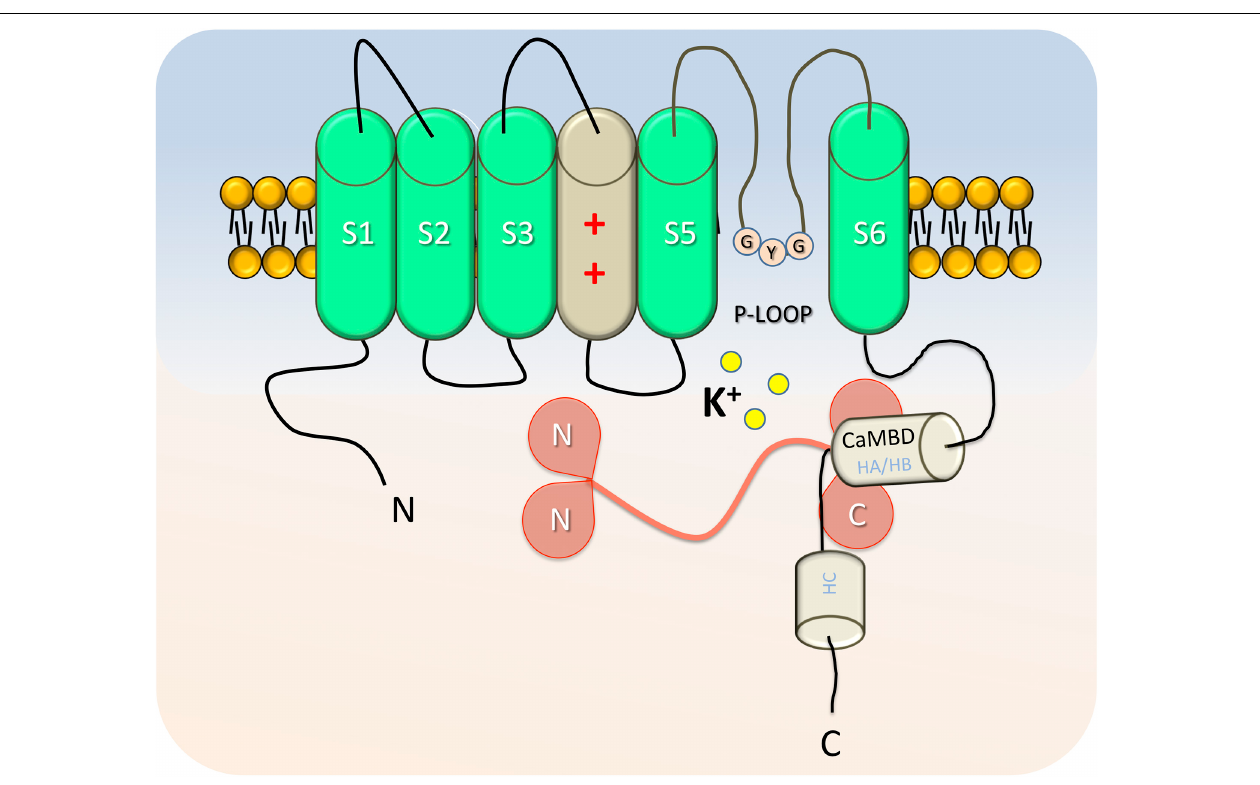
FIGURE 1 | Representative cartoon of a SK4 α -subunit in absence of calcium. Each monomer is formed by six transmembrane domains (S1–S6), which are prolonged by cytoplasmic N and C termini. S4 is the voltage sensor, with positively charged amino acids. The segment (P-loop) between S5 and S6 forms the pore of SK4 and includes the GYG “selectivity filter” for potassium. The Calmodulin binding domain (HA and HB helixes), binds Calmodulin on the C-lobes. In low [Ca 2 + ] i conditions, the N-lobes of Calmodulin are free and positioned closely to the S2-S3 intracellular segment. Helix C, toward the cytosol is involved in the assembly of the α -subunits as a functional